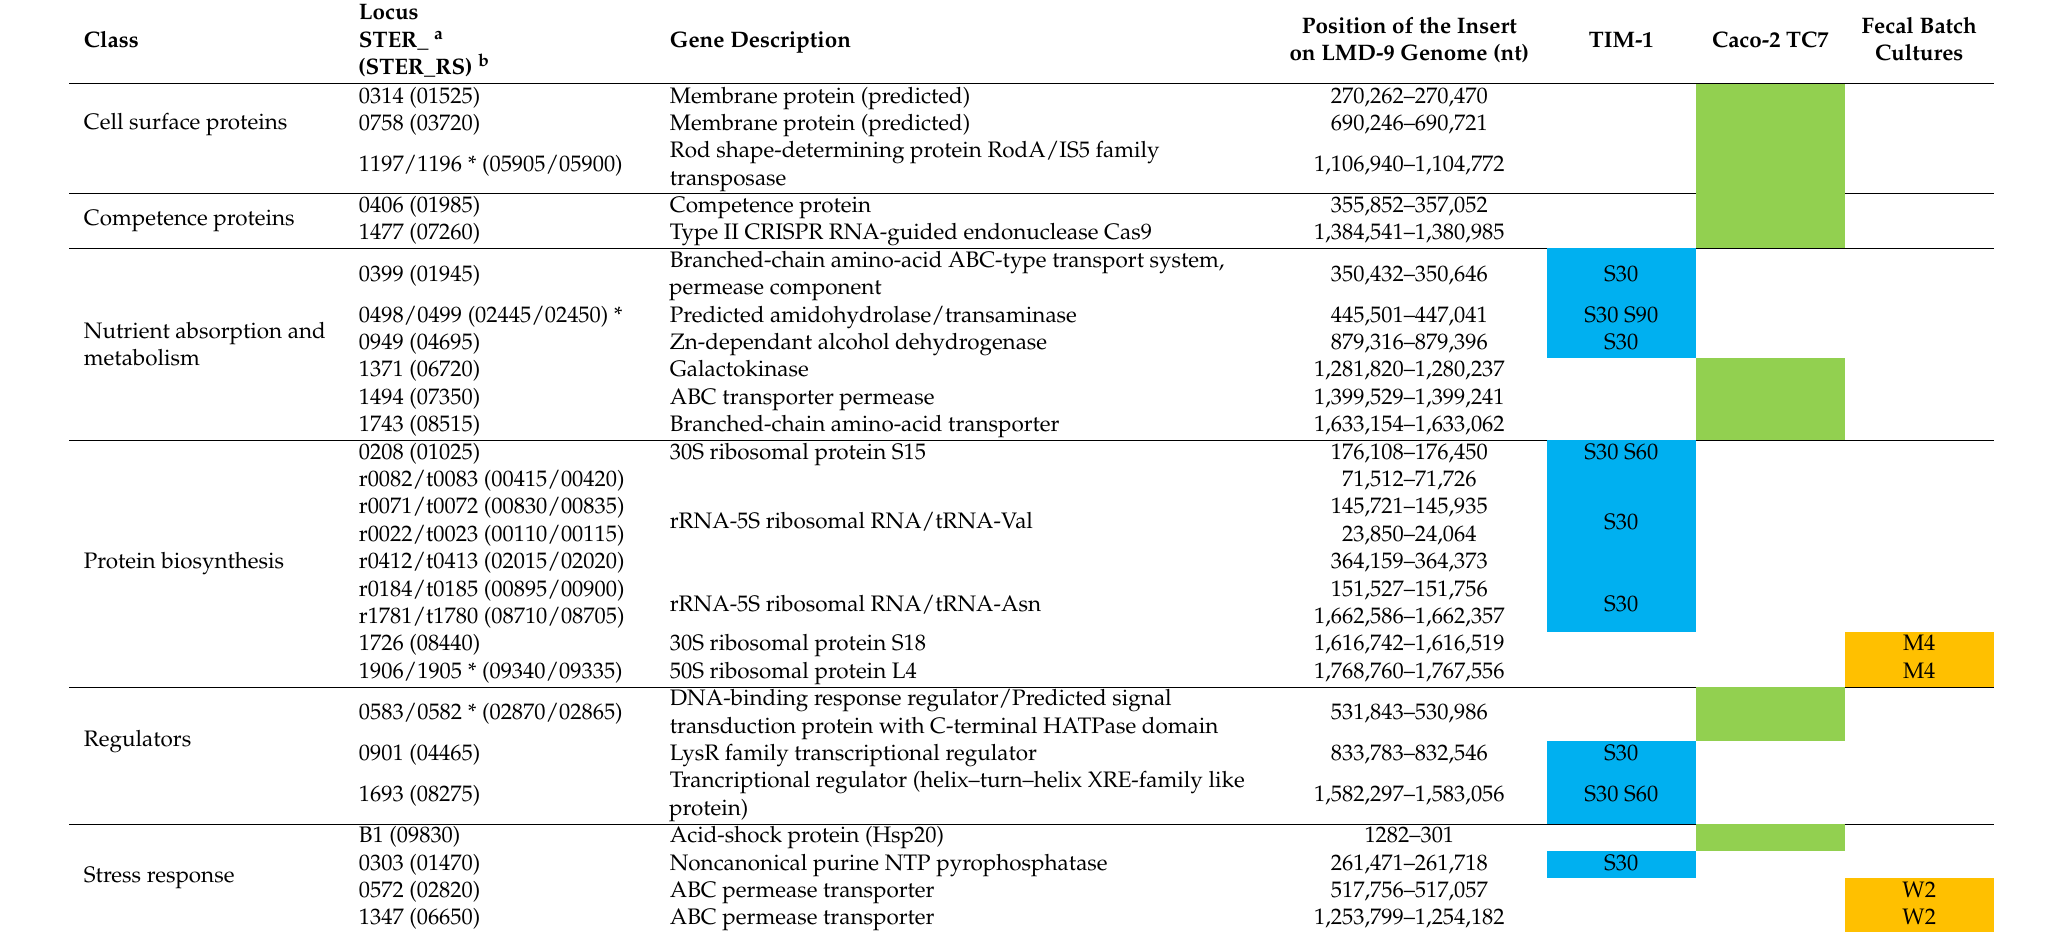
Table 3. Inserts from activated R-IVET library clones identified under simulated human digestive conditions and found in the annotated S. thermophilus LMD-9 genome.